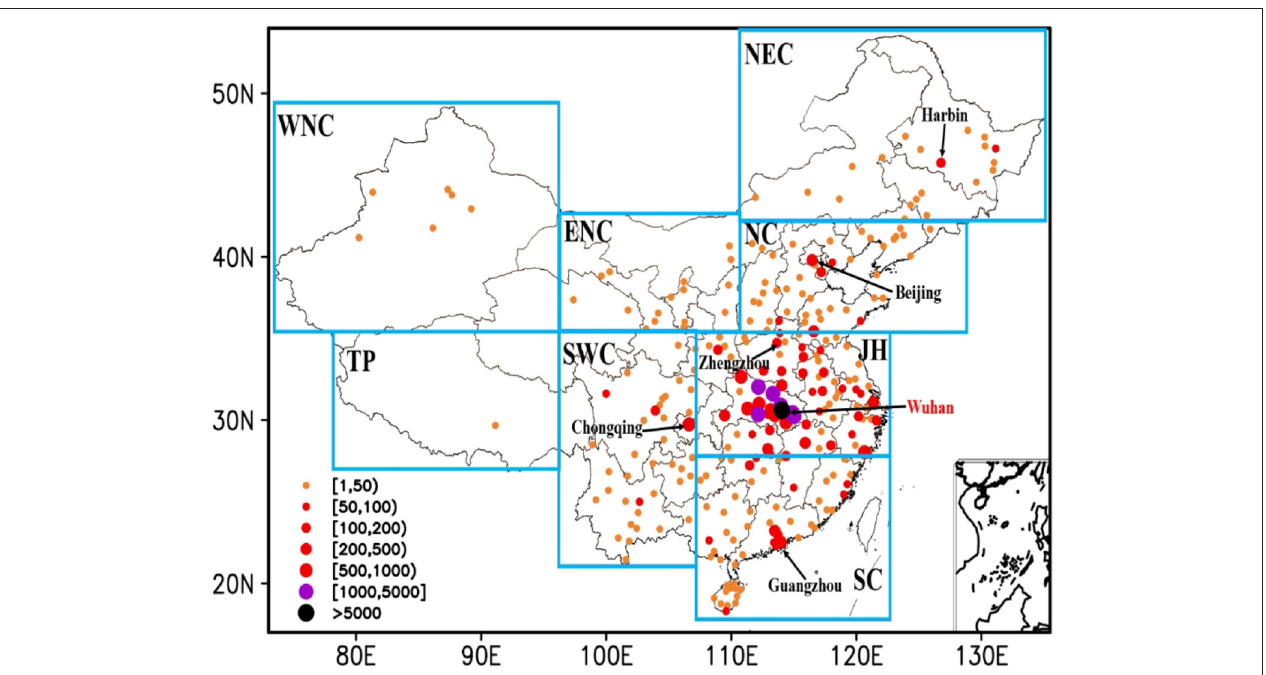
FIGURE 1 | Distribution of confirmed cases in China as of February 25, 2020. The lower right corner is the South China Sea islands. The eight subregions are Northeast China (NEC, 42.25 ◦ N − 54.75 ◦ N, 110.25 ◦ E − 135.25 ◦ E), North China (NC, 35.25 ◦ N − 42.25 ◦ N, 110.25 ◦ E − 129.75 ◦ E), Jianghuai (JH, 27.25 ◦ N − 35.25 ◦ N,